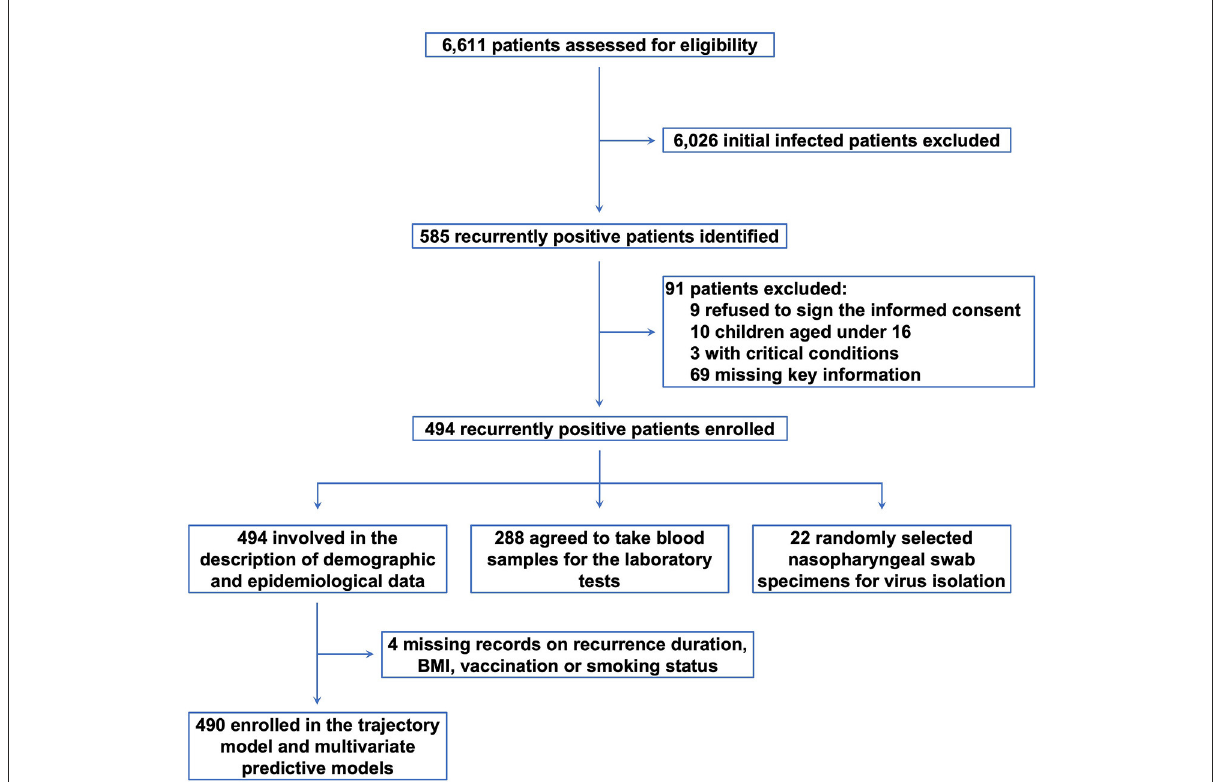
FIGURE1 The study diagram. From May 12 through June 10, 2022, we identified 6,611 patients with SARS-CoV-2. After excluding 6,026 patients with initial infection and 91 ineligible participants, 494 subjects were enrolled for the